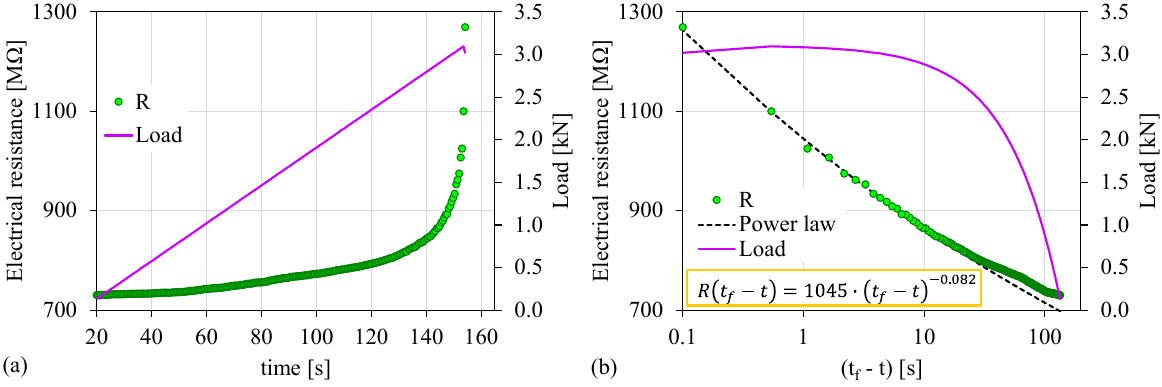
Figure 6. ( a ) The temporal evolution of the electrical resistance ( R ) in juxtaposition to the load applied for the experiment Exp-LR2; ( b ) the respective temporal evolution of the recorded electrical resistance ( R ) in terms of the “time-to-failure” parameter.